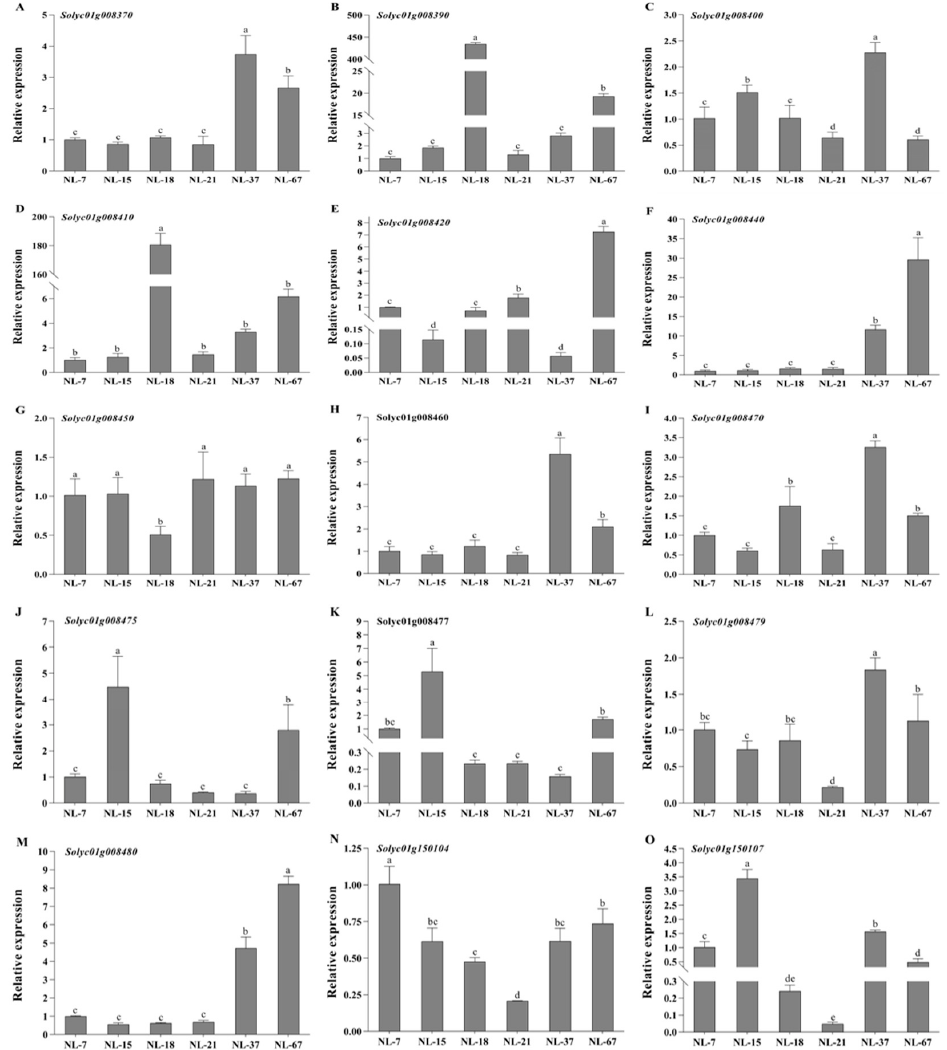
Figure 5. The expression profiles of the identified genes within 50 kb upstream and downstream